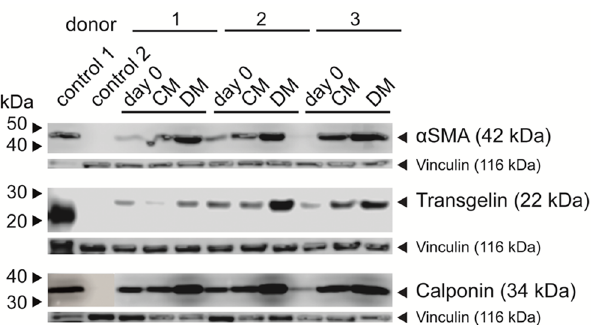
Fig 3. Expression of contractile SMC-specific proteins analyzed by Western blot. MSCs from three donors were treated with control medium (CM) or SMC differentiation medium (DM) for 0 or 14 days and the expression pattern of α SMA, transgelin and calponin was compared to the positive control (control 1: bladder tissue) and the negative control (control 2: PBMCs) by Western blot. Representative of n =